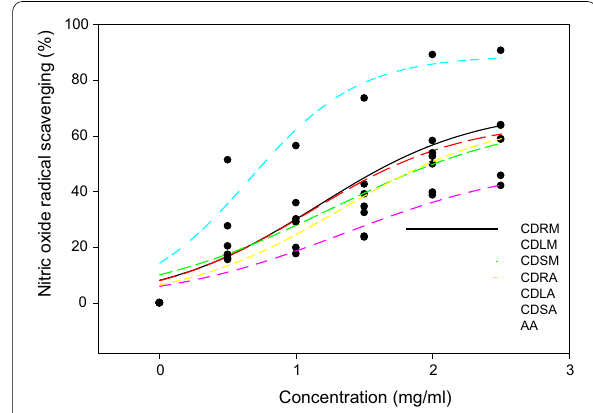
Fig. 3 Nitric oxide radicals scavenging activities of crude aqueous and methanol extracts of leaves, stem and roots of C. dependens and ascorbic acid